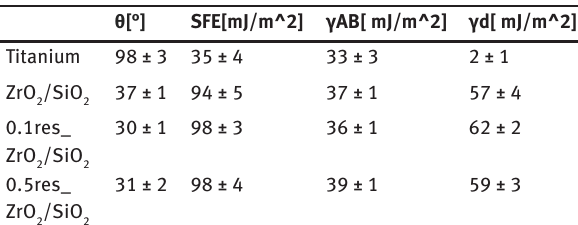
Table 2: Wettability properties of substrate and synthesized